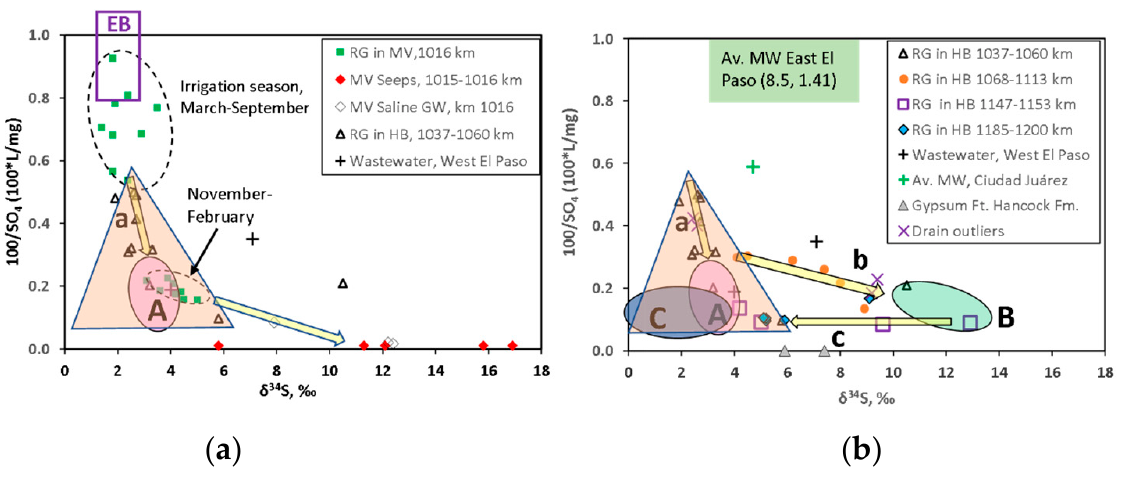
Figure 7. Reciprocal sulfate concentration vs. δ 34 S for Rio Grande (RG) surface water: ( a ) for surface water entering the Hueco Bolsón (HB) from Mesilla Valley (MV). ( b ) for the river in the Hueco Bols ó n. HB, MV = Rio Grande water from the Hueco Bols ó n, Mesilla Valley respectively. River locations shown as km from the source. Block arrows indicate mixing trends a, b and c (see text) and sulfate mixing in non-irrigation season surface water at km 1016 near the terminus of Mesilla Valley; A, B and C are proposed end member compositions for mixing trends a, b and c, respectively. Av. MW = arithmetic average of data for municipal supply wells sampled in this study. Data for Mesilla Valley (Rio Grande surface water, salt seeps and wastewater in West El Paso) are from [7,39]. Other data are from this study and